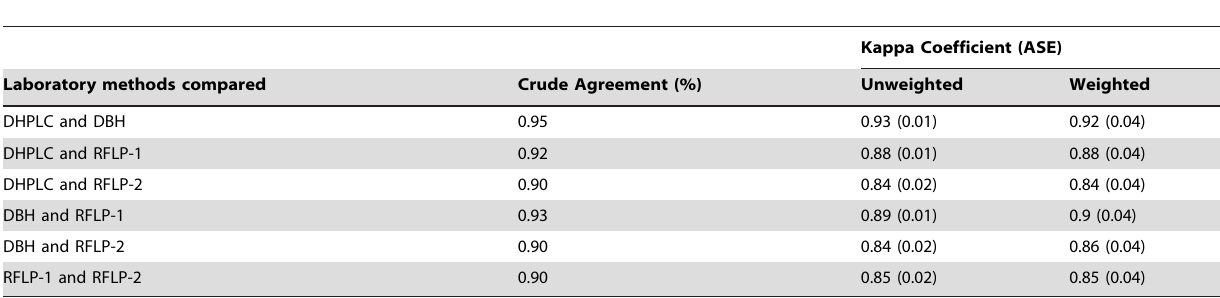
Table 2. Pairwise comparison of agreement among laboratory methods using crude agreement percentages and kappa